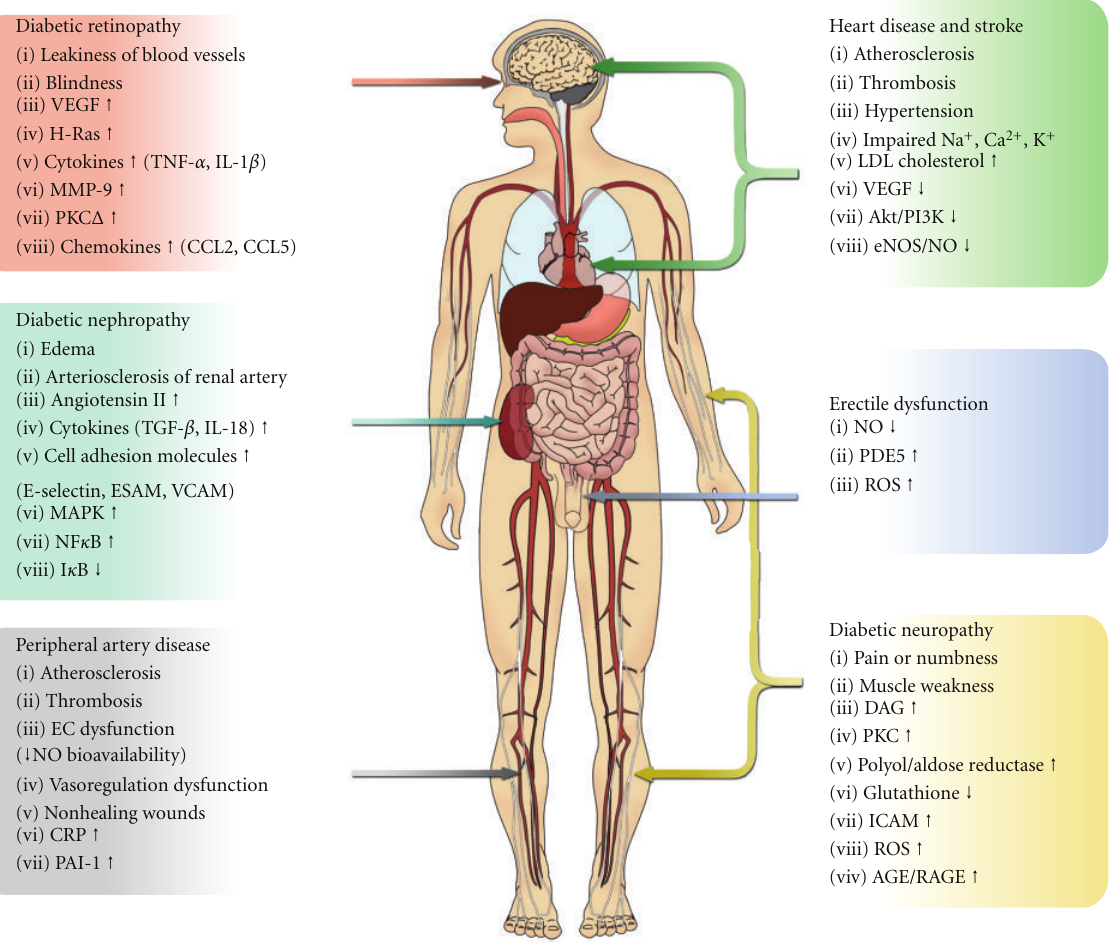
Figure 1: Diabetic vascular disease e ff ects and symptoms. Various pathophysiological conditions a ff ected in the body due to diabetic vascular disease are illustrated. Prominent symptoms of diabetes mediated abnormalities are indicated for each